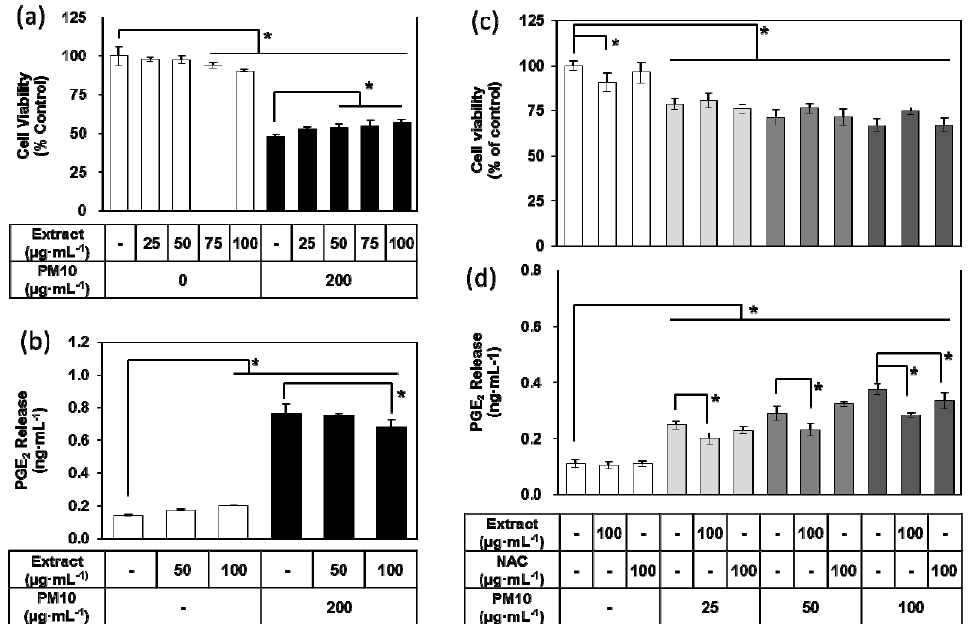
Figure 3. Effects of Ecklonia cava extract on the viability and PGE 2 release of HaCaT keratinocytes exposed to PM10. Cells were treated with PM10 in the absence or presence of E. cava extract or N-acetyl cysteine (NAC) for 48 h for the viability assay ( a,c ) and for the PGE 2 assay ( b,d ). Data are presented as a mean ± SD ( n = 4). All treatments were compared to the PM10 control using one-way ANOVA followed by Dunnett’s test. * p < 0.05.